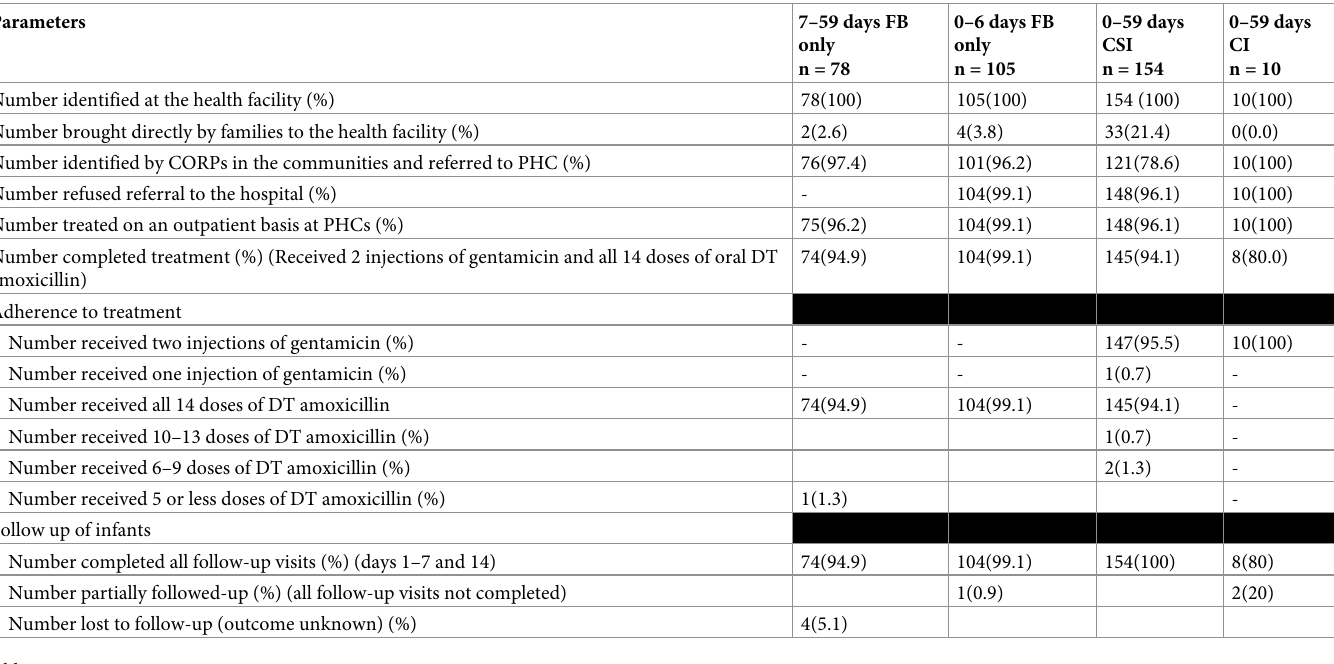
Table 2. Treatment adherence and follow-up of Young Infants 0–59 days old with signs of PSBI (n =